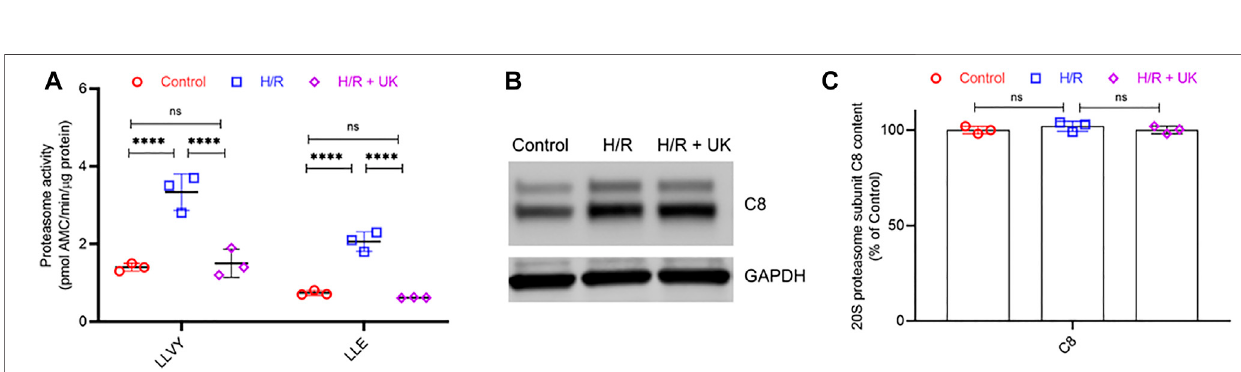
Frontiers in Pharmacology |